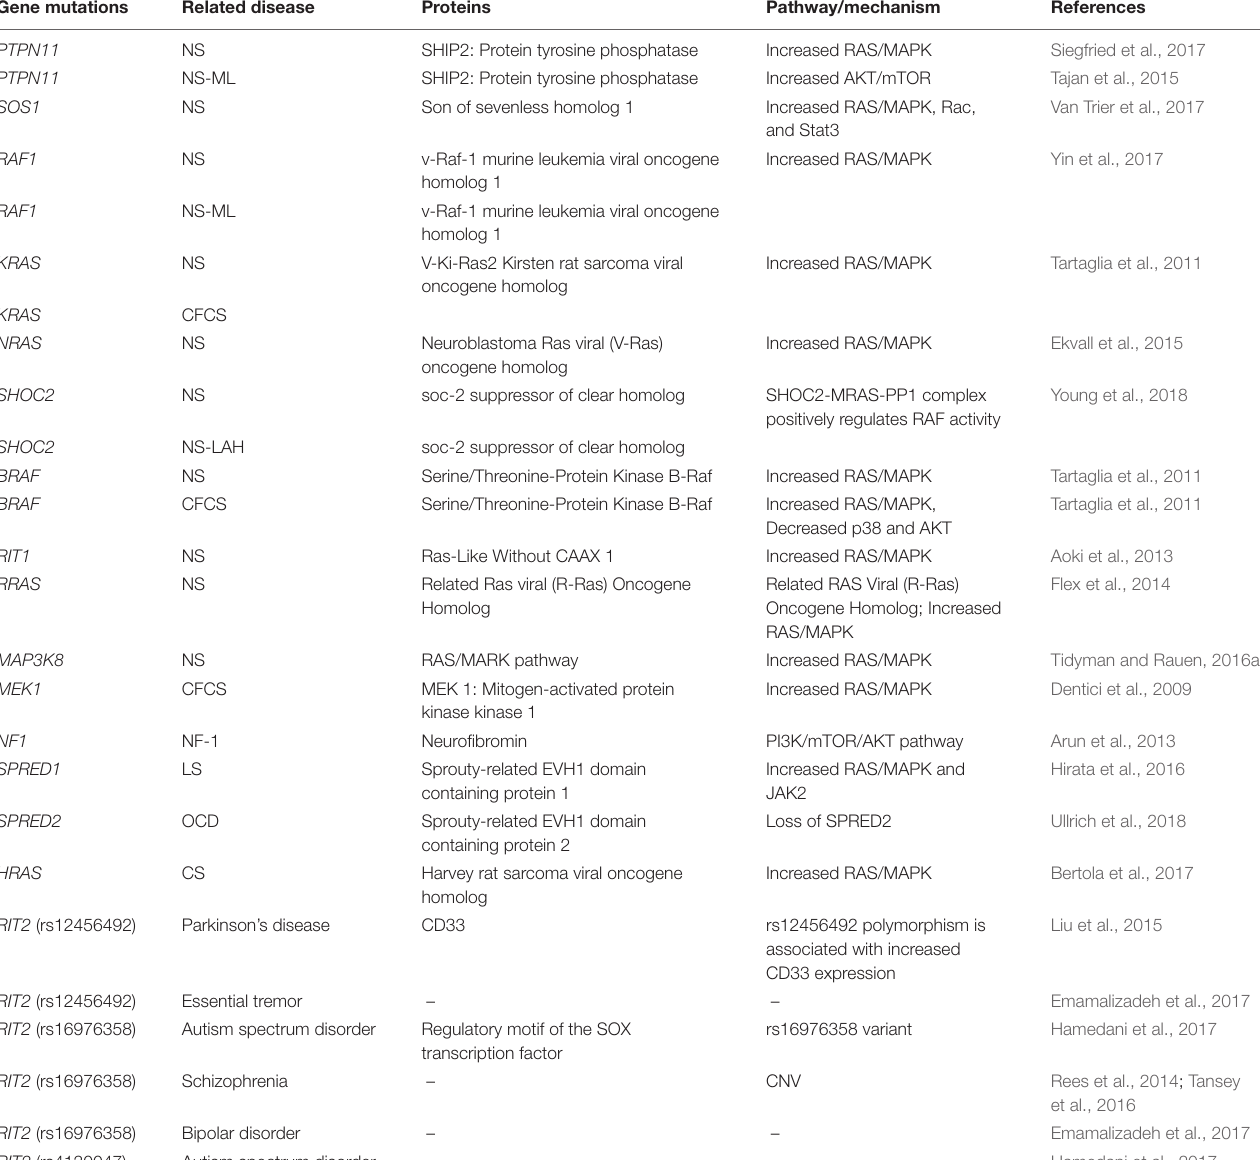
TABLE 1 | Gene mutations related to Small GTPases (Ras